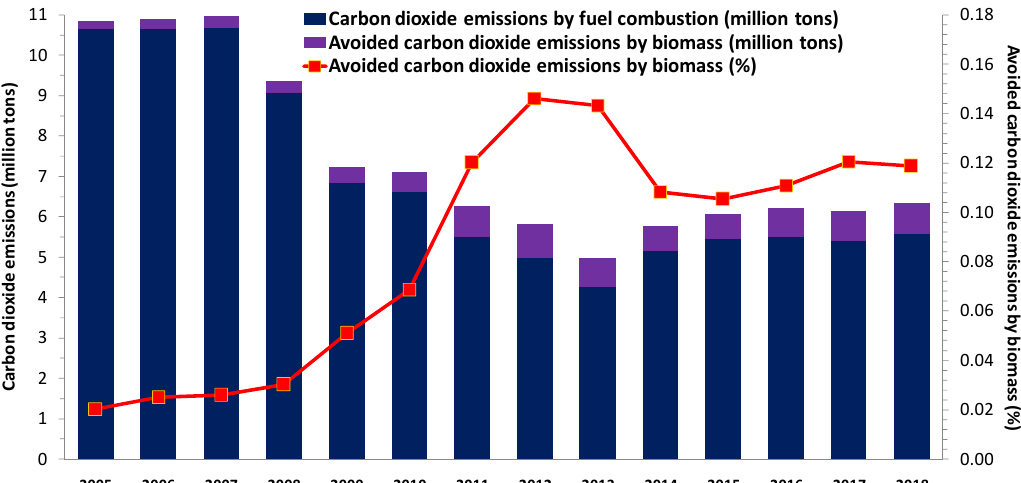
Figure 6. Carbon dioxide combustion emissions and avoided CO 2 emission by biomass in the Spanish cement industry from 2005 to 2018 (millions of tons).